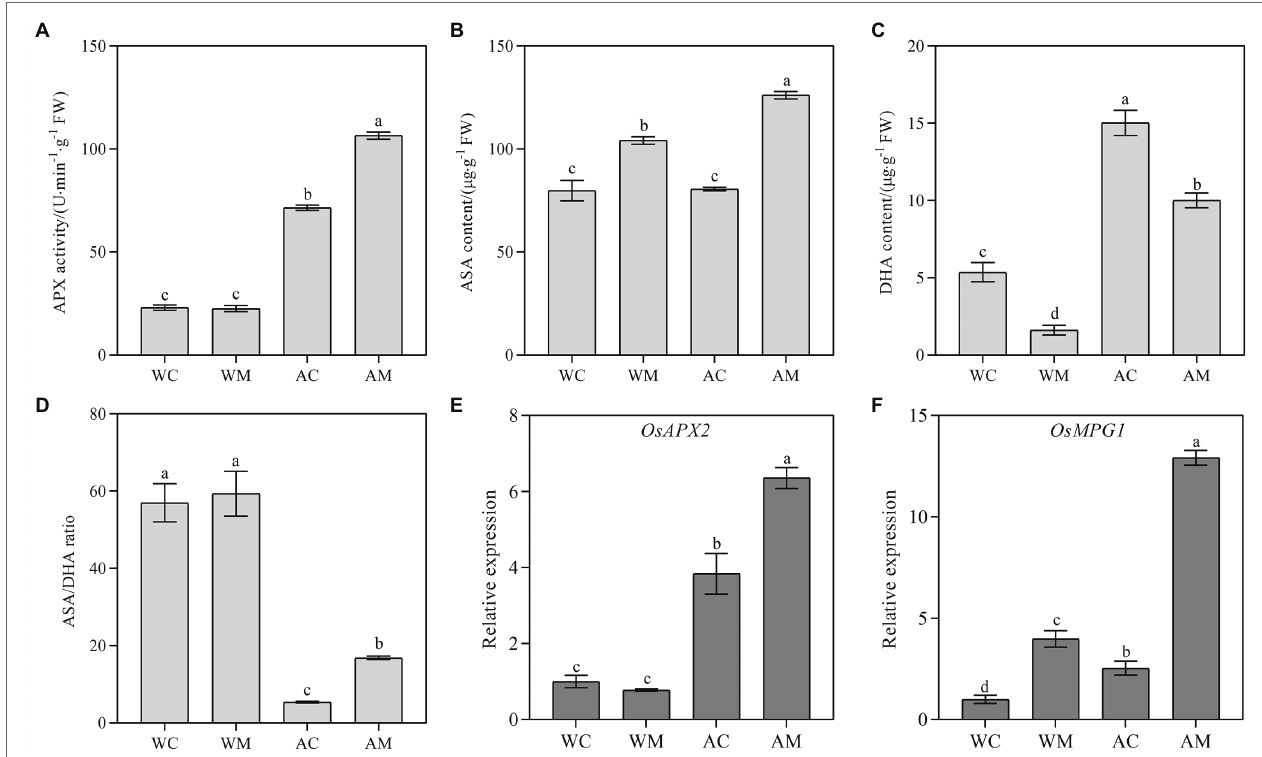
FIGURE 6 | Effects of exogenous MT on APX activity, ASA, DHA content, and antioxidant-related genes. (A) APX activity; (B) ASA content; (C) DHA content; (D) ASA/DHA; and (E,F) OsAPX2 and OsMPG1 relative expression. Data represent means ± SEs of three replicate samples. Different letters denote significant differences ( n = 3, and p < 0.05). WC, control; WM, control pretreated with MT; AC, alkaline stress; and AM, alkaline-stressed plants pretreated with